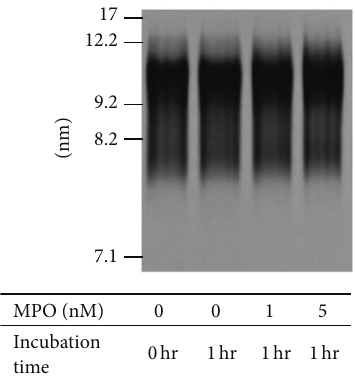
Figure 2: Effects of MPO treatment on HDL particle size. HDL treated with MPO (0, 1, or 5 nM) for 1hr was subjected to nonde- naturing PAGE followed by CBB R-250 staining. The particle sizes (nm) of the standards are listed on the